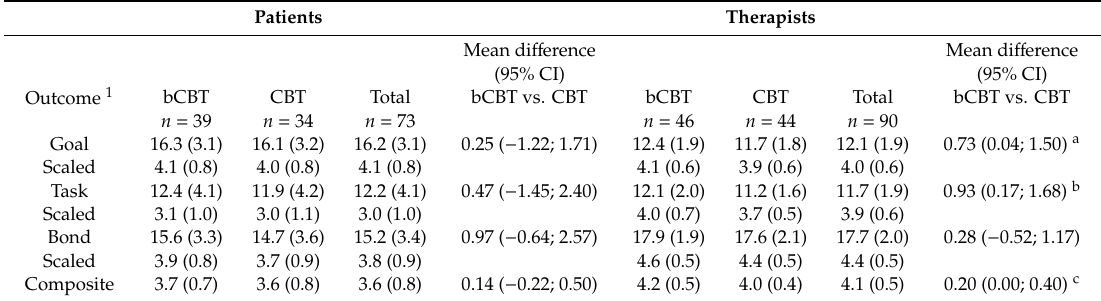
Table 3. Patient- and therapist-rated working alliance in the two treatment